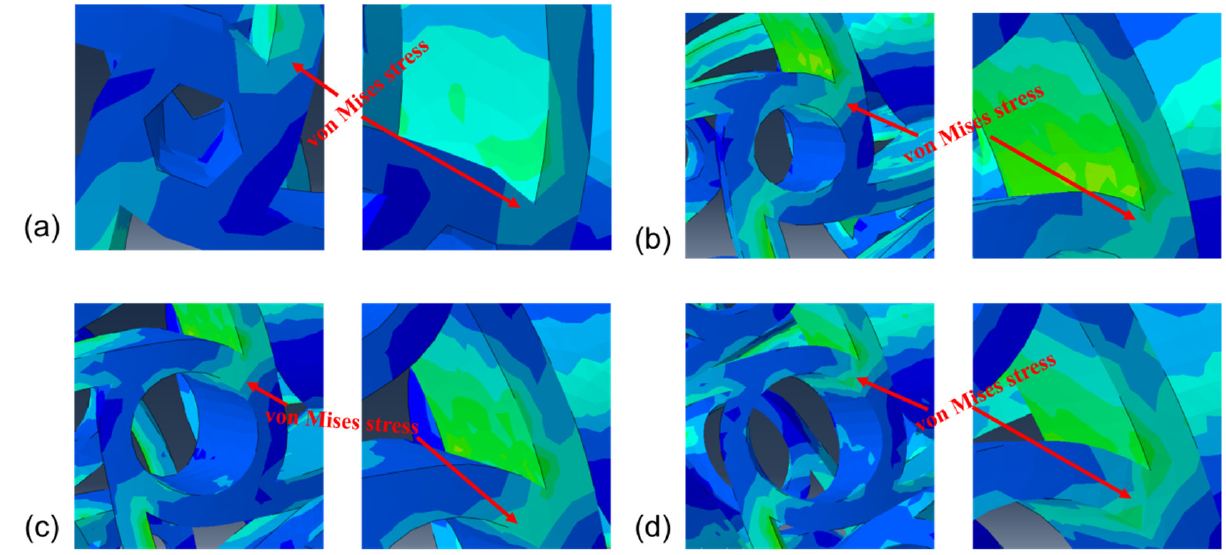
Figure 7. Effect of different radii on stress distribution: ( a ) r = 0.6 mm; ( b ) r = 0.9 mm; ( c ) r = 1.2 mm; ( d ) r = 1.5 mm.